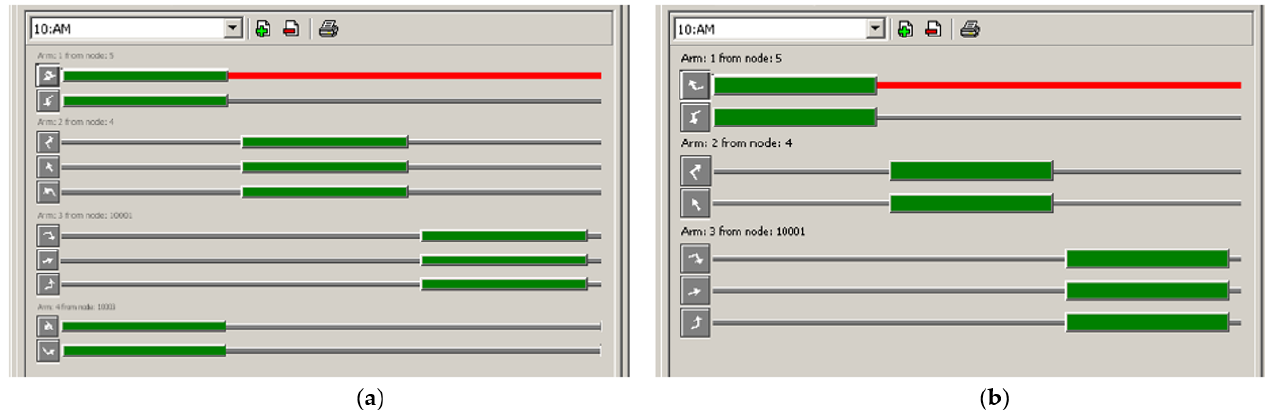
Figure 8. Illustration of the signal plan of the Palackeho – Stefanikova intersection for Variant A ( a ) and Variants B and C ( b ) (source elaborated by authors).